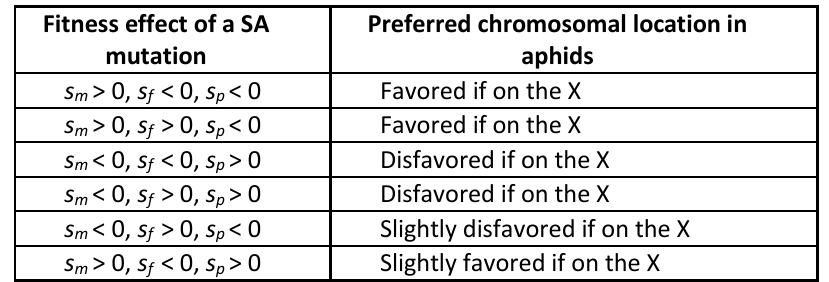
Table 1: Preferred chromosomal location (X chromosome versus autosomes) of different types of alleles with morph-antagonistic effects ( s m , s f and s p stand for the selective coefficient of the new variant on males, sexual females and parthenogenetic females, respectively). Predictions originate from analytical and simulation models developed in Jaquiéry et al.